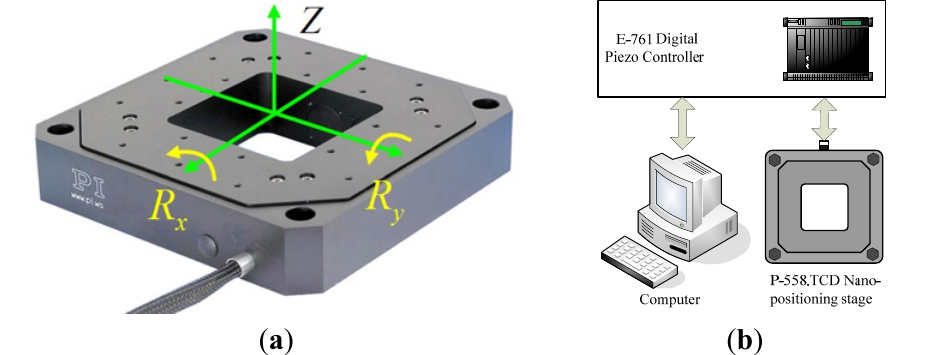
1. Experimental settings on the piezo-actuator-driven stage: ( a ) picture and ( b )